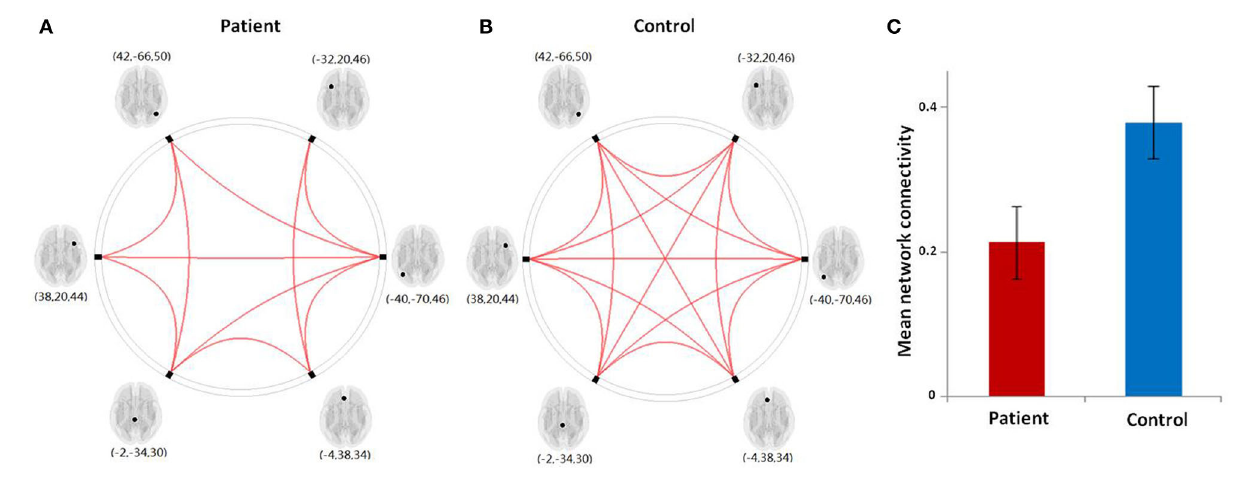
FIGURE 5 | (A,B) Graphical presentation of the left frontoparietal network in aphasic patient and healthy control groups separately identified by network connectivity analysis analysis. A threshold of